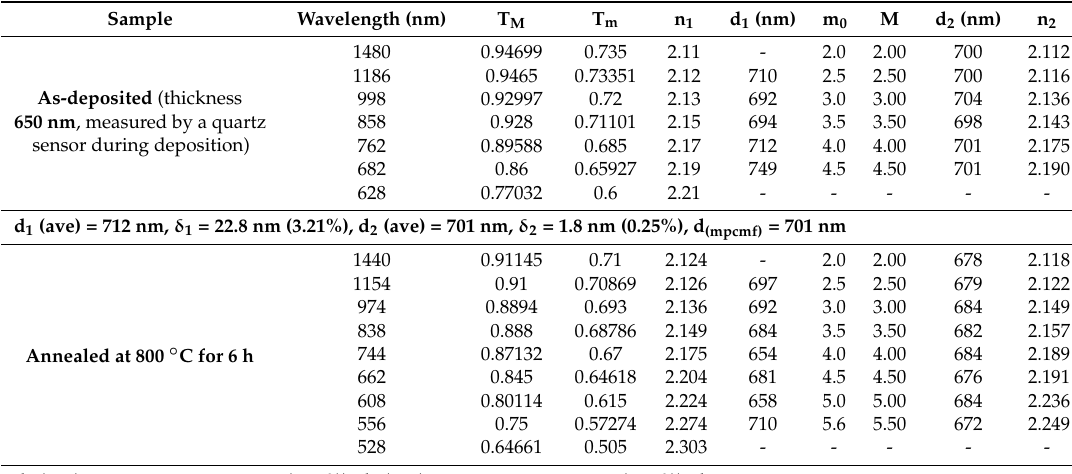
Table 1. Optical parameters obtained from the optical transmission measurements carried out using the first batch (as-deposited and annealed) of garnet samples.